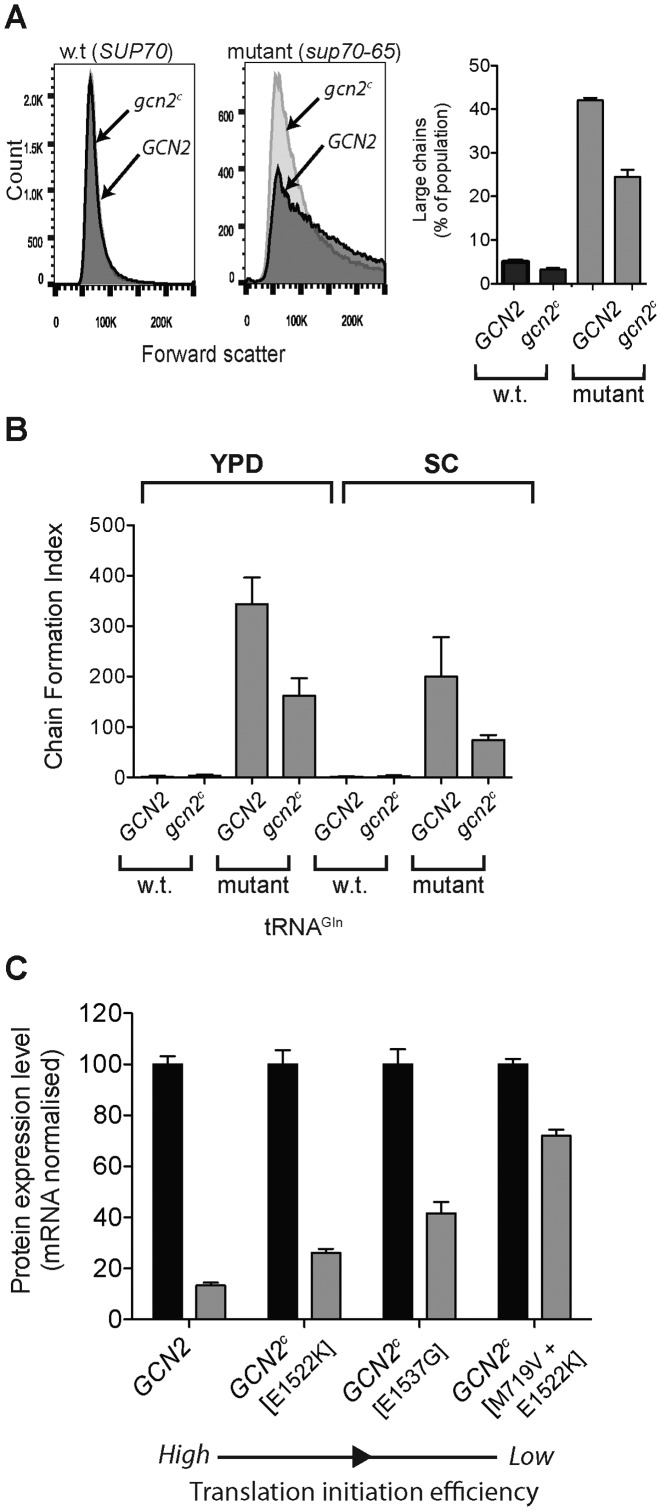
Reductions in the global translation initiation rate ameliorate the mRNA-specific translational inefficiencies caused by reduced \documentclass[12pt]{minimal}
\usepackage{amsmath}
\usepackage{wasysym}
\usepackage{amsfonts}
\usepackage{amssymb}
\usepackage{amsbsy}
\usepackage{upgreek}
\usepackage{mathrsfs}
\setlength{\oddsidemargin}{-69pt}
\begin{document}
}{}${\rm{tRNA}}_{{\rm{CUG}}}^{{\rm{Gln}}}$\end{document} concentration. (A) Cell cytometry was used to assay the prevalence of pseudohyphal chains that typify the sup70-65 mutant. Forward scatter measurements indicated the extent of formation of large chains of cells. Pseudohyphal growth was assessed in wild-type and sup70-65 yeast in the presence of either a wild-type ectopic GCN2 allele (dark-shaded frequency plot), or a constitutively-active gcn2c allele (light-shaded). Population sizes of large chains and single budded cells were quantified using the cytometry data and plotted in the bar chart. (B) To confirm these observations, the degree of pseudohyphal chains formation in wild-type or sup70-65 cells, transformed with a plasmid expressing either CGN2 or gcn2c was assessed by direct microscope observation. Pseudohyphal chains were counted, and a chain formation index used to capture the extent of pseudohyphal growth during growth on complete (YPD) or minimal medium (SC) (6). (C) HA-tagged FAR7 was expressed in wild-type and sup70-65 yeast transformed with ectopically expressed CGN2 or gcn2c genes to either maintain, or reduce, global translation initiation rates respectively. Three different gcn2c alleles were used with increasing degrees of constitutive eIF2 phosphorylation activity (E1522K < E1573G < M719V, E1522K). FAR7 expression was quantified using Western blotting, normalised for mRNA expression level as in Figure 3 (n = 3, ± standard error of the mean). The Far7p expression level in the mutant sup70-65 was expressed as a percentage of the expression level in a wild-type cell.